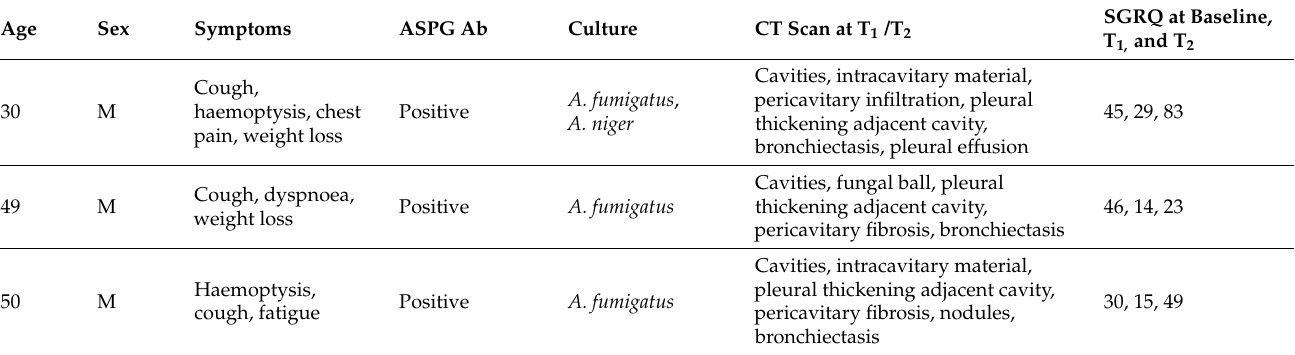
Table 2. Demographics, symptoms, laboratory, imaging and QoL details of the three CPA patients.